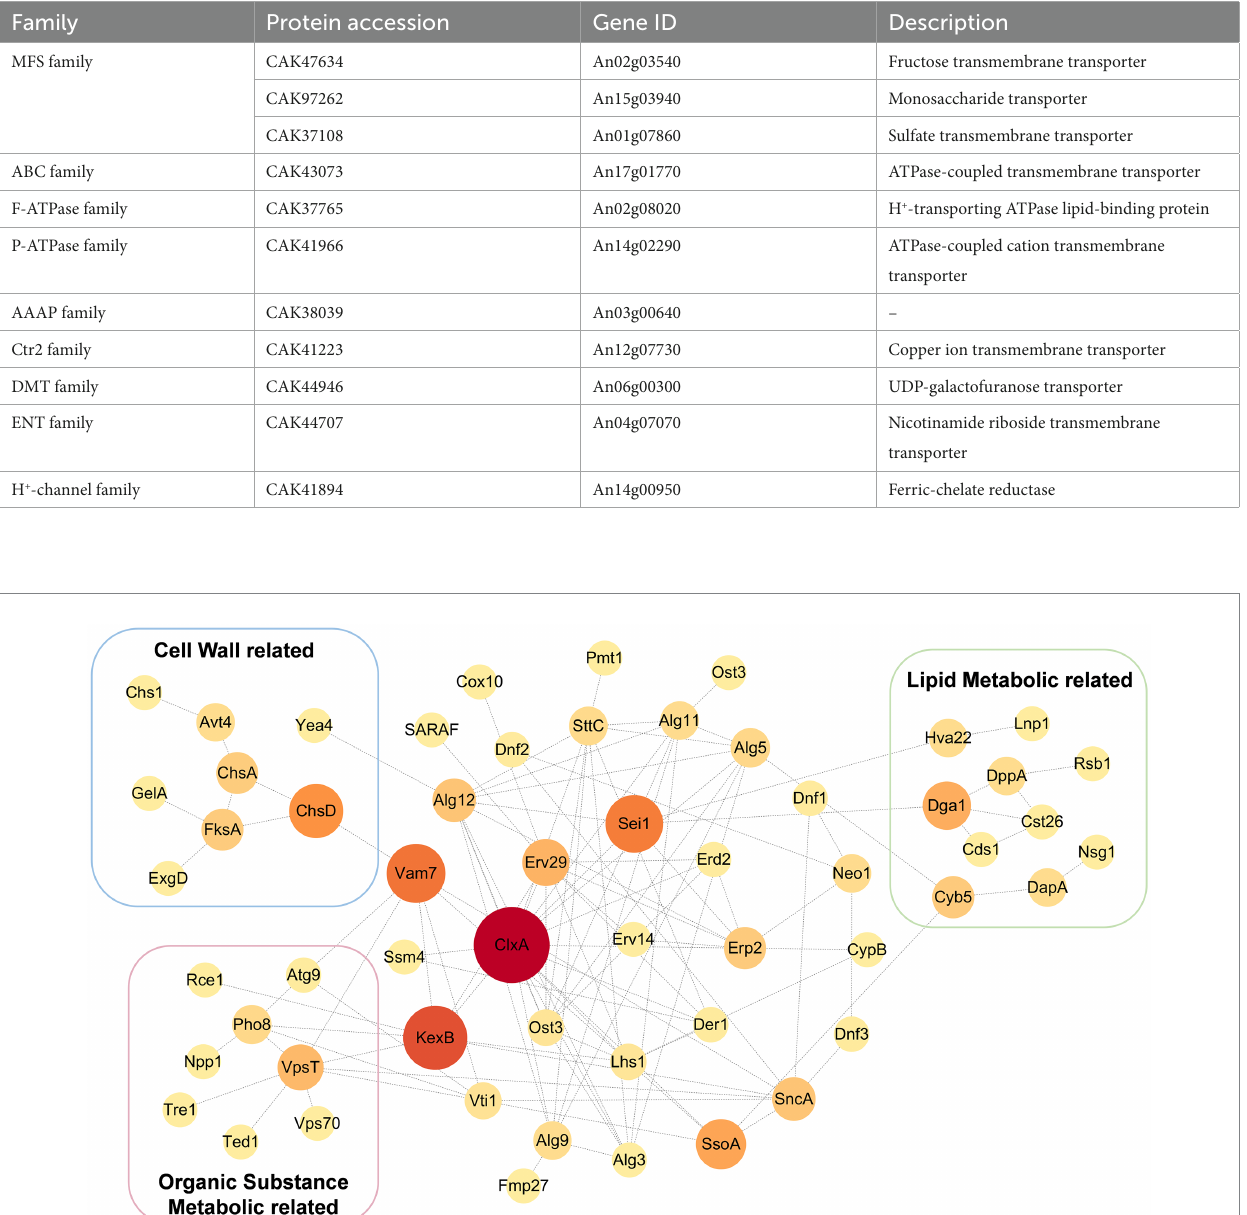
TABLE 1 Transporters identified in the down-regulated proteins of proteome and the Y2H